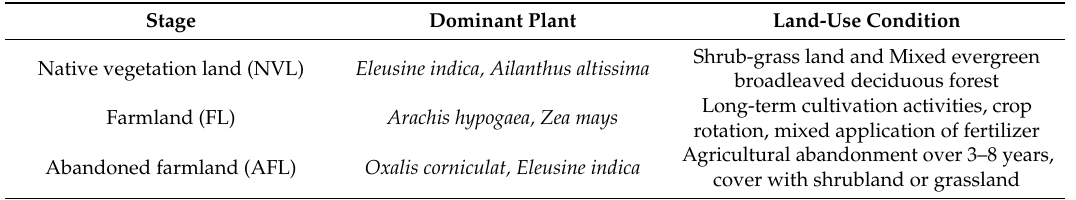
Table 1. The information on the land-use condition in three types stage.